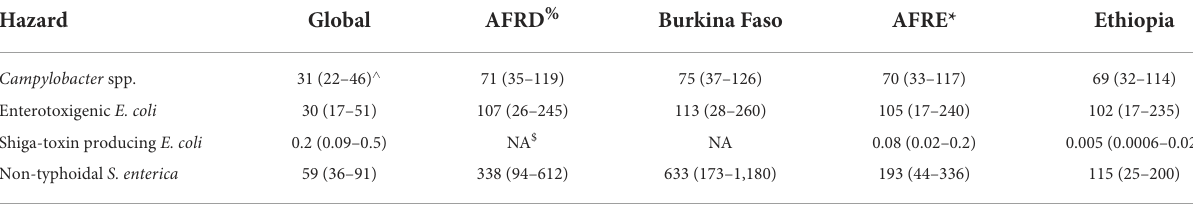
TABLE 1 Foodborne disability-adjusted life years (DALY) per 100,000 population for four bacterial hazards for the global population, subregions AFRD and AFRE, Burkina Faso and Ethiopia in 2010 according to WHO FERG (Havelaar et al., 2015). Hazard Global AFRD